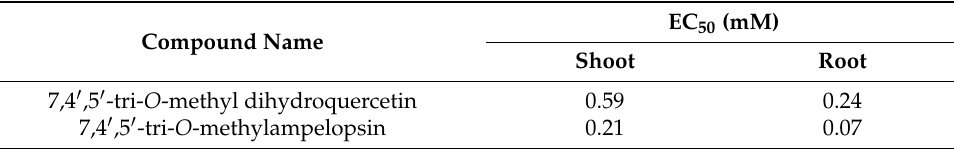
Table 2. EC 50 values of 7,4 (cid:48) ,5 (cid:48) -tri- O -methyl dihydroquercetin and 7,4 (cid:48) ,5 (cid:48) -tri- O -methylampelopsin for the growth of cress